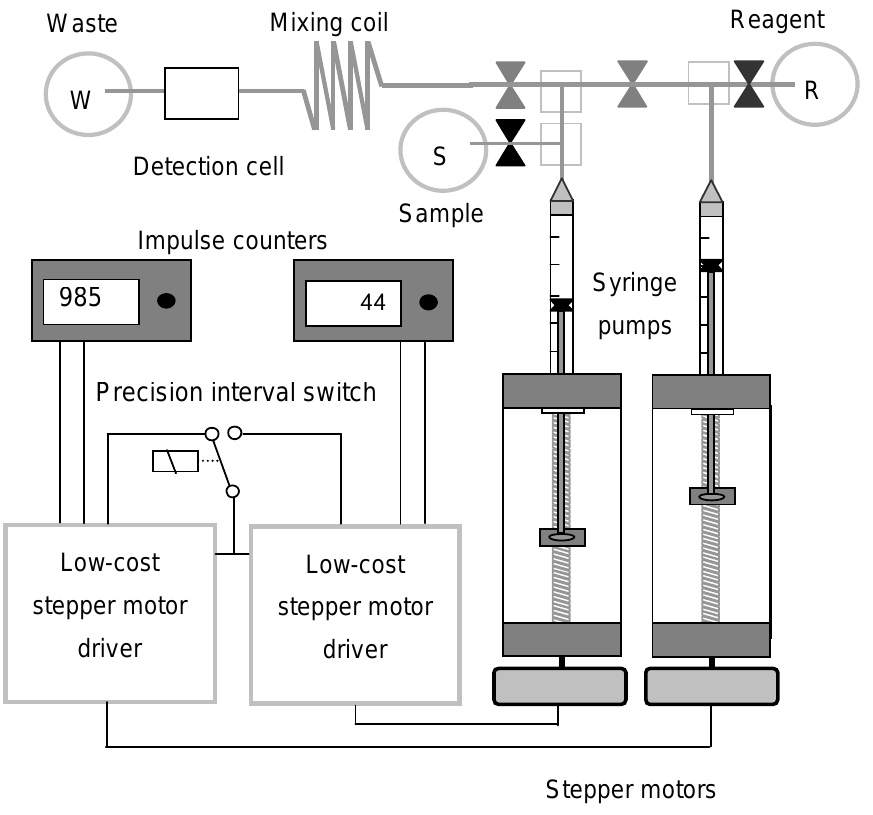
Figure 4. The low-cost simplified FIA set-up with time-based injection, the assembling of which we suggest for low-budget circumstances and which we used for testing the proposed spectrometric detector for real-life applications in the blue and red light